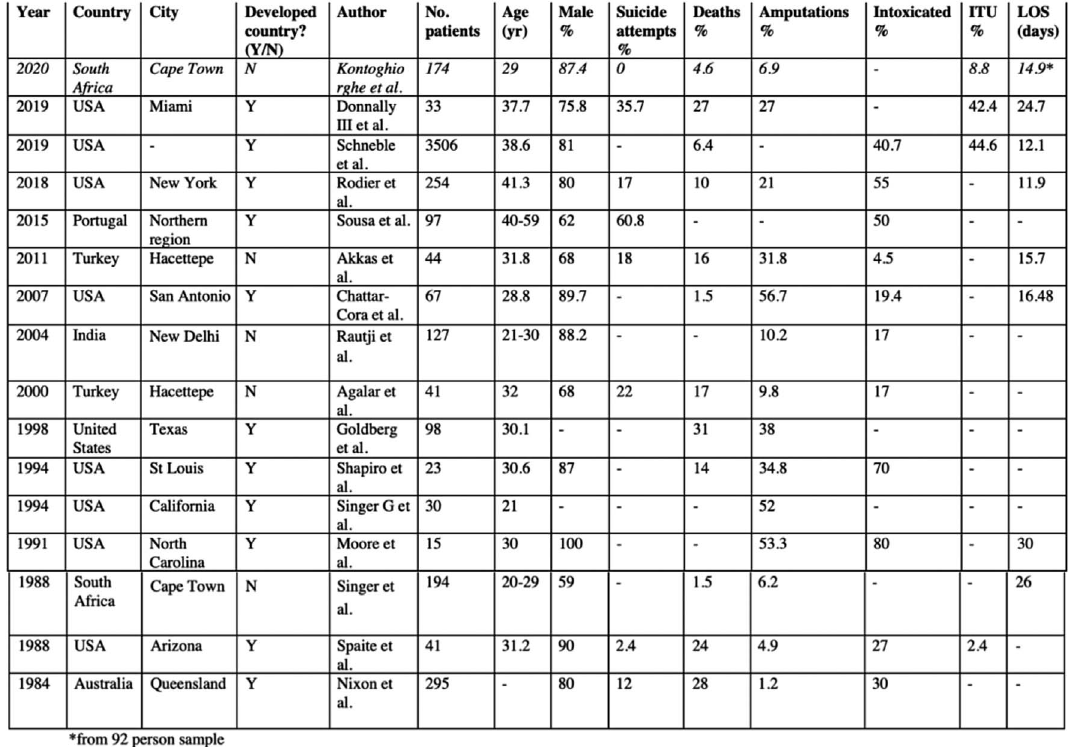
Figure 4. Summary of literature review fi ndings. Salient points are noted, including the year of publication, country/city, whether this is a developed or developing country, authors, number of patients in the study, mean age, percentage male, suicide attempts, mortality rate, amputation rate, intoxication rate, percentage of patients requiring intensive care admission, and the average length of stay